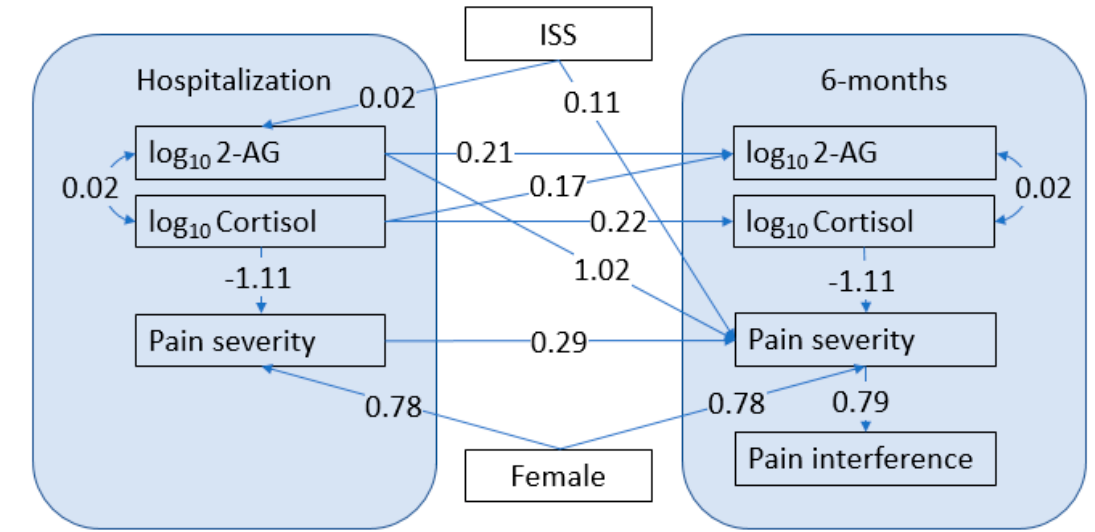
Figure 1. Model of the Relationship of Traumatic Pain, Cortisol, and Endocannabinoid Levels. The numbers on the arrows are regression coefficients, representing the effect of a 1-unit increase in the predictor on the outcome. For the log-transformed biomarkers, a 1 unit increase on the log scale corresponds to a 10-fold increase in the original value. All coefficients shown are significant with p < 0.05.